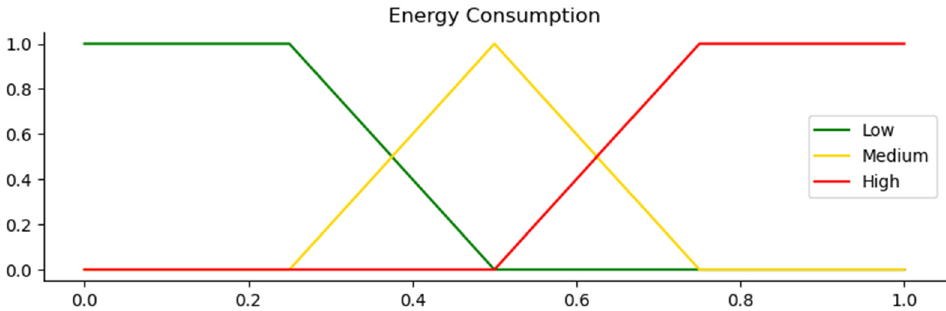
Figure 5. Membership function of Criterion 3 (Equation (3)) of energy consumption.